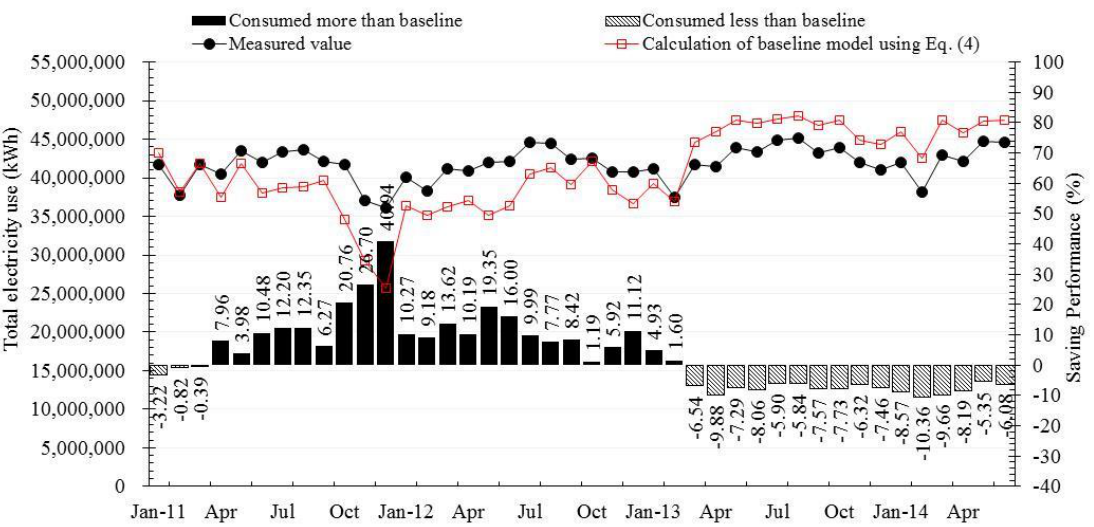
Figure 5. Monthly electricity consumptions and calculations using Equation (4) from January 2011 to June 2014.